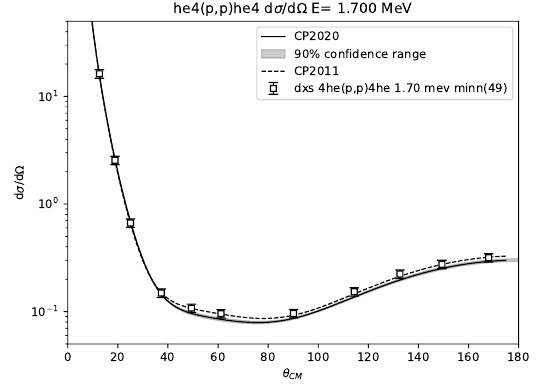
Figure 7. The angular distribution for 4 He( p , p ) 4 He for deuteron incidentlaboratoryenergy1.7MeVoftheunpolarizeddifferential cross section in the center of mass as a function of the center of mass angle θ cm . The evaluation is shown by the solid curve. The gray band is the 90% confidence interval determined as described in the text.